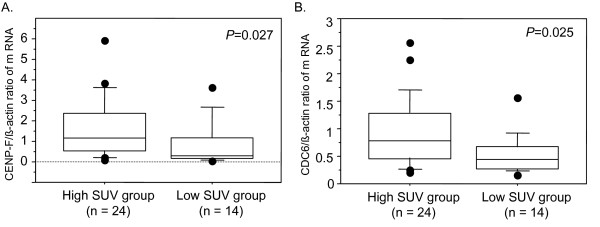
The relative expression levels were calculated against the levels of β-actin expression. Mann-Whitney test was performed to confirm the statistical significance of expression levels of CENP-F and CDC6 in breast cancer tissues between patients in low SUV group and those in high SUV group. The bars represent (A) the ratio of the expression level of CENP-F to that of β-actin expression level and (B) the ratio of the expression level of CDC6 to that of β-actin. Empty and filled bars represent a case of the low SUV group and high SUV group, respectively.